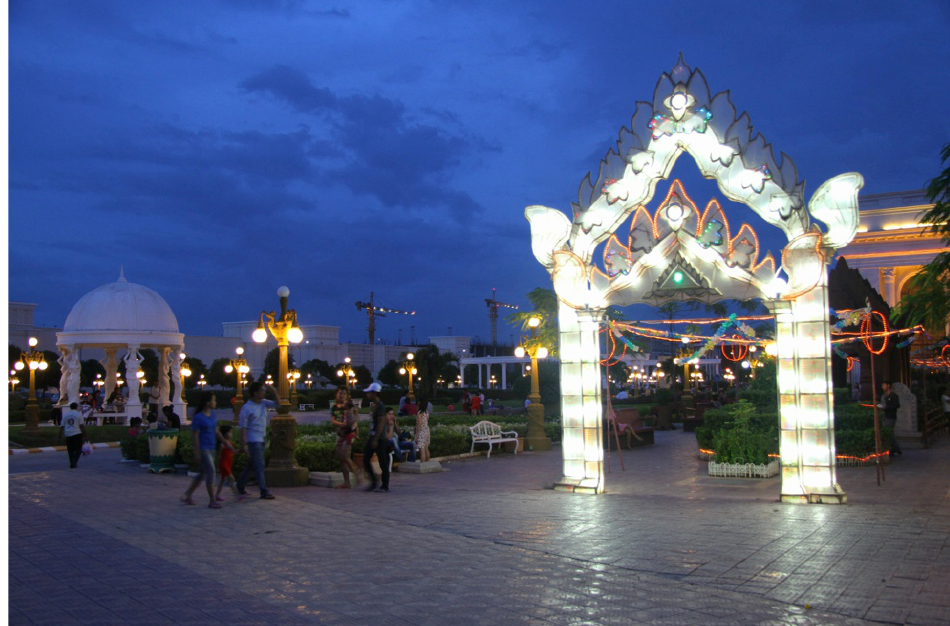
Designer unknown, unnamed khlaong twie (pagoda entrance gate), Koh Pich (Diamond Island), Phnom Penh, 2013. Photograph by Roger